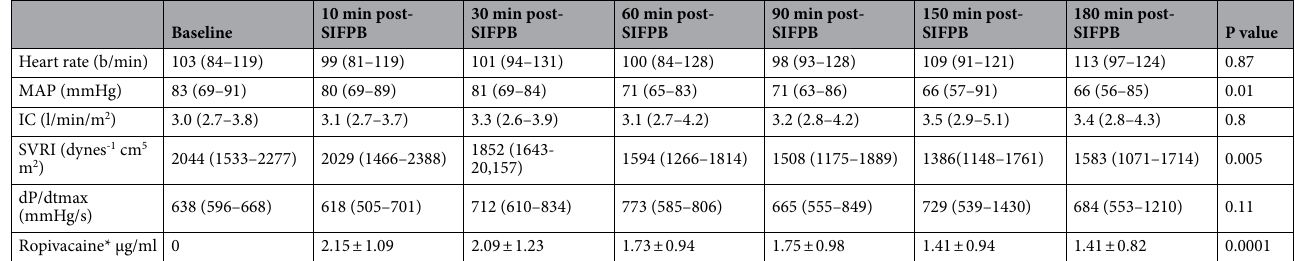
Table 4. Hemodynamic variables on the baseline, and 10, 30, 60, 90, 150 and 180 min after serratus intercostal fascial plane block. Data are shown as medians and interquartile range (IQR). SIFPB serratus intercostal fascial plane block, SAP systolic blood pressure, DAP diastolic blood pressure, MAP mean arterial pressure, dP/dt max peak first derivative of femoral artery pressure, SVRI systemic vascular resistance index. *Arterial ropivacaine